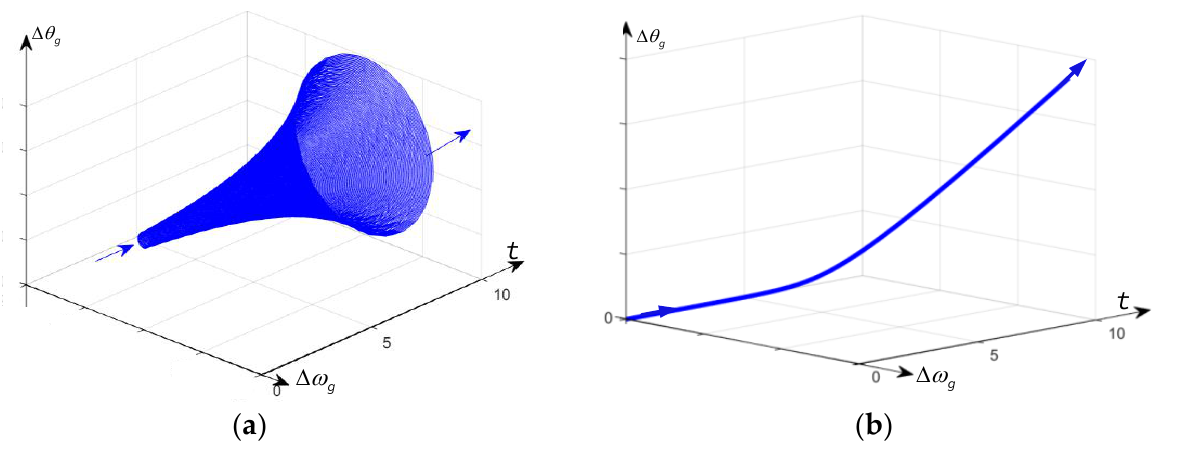
( b ) Figure 7. Phasor diagram for demonstrating the leading effect of damping torque on internal voltage stability: ( a ) normal condition; ( b ) abnormal condition with changed damping torque under dis- turbances. 3.4. Proposed Synchronverter Controller Design When disturbances such grid dip occur, the internal voltage of VSC in RPL is likely to oscillate and in turn deteriorate the APL stability. Since the droop coefficients in APL and RPL in synchronverters re hard to change due to the influence of steady-state droop characteristics, designing another auxiliary control loop would be a desirable method to improve the transient stability. In this paper, an auxiliary correction loop is proposed and added between APL and RPL, which is addressed by the red line in Figure 8; the power interface with the grid is the same as Figure 1 and neglected here. The input of the correc- tion control loop is Ψ f , and its output is obtained by the high-pass filtering of Ψ f , where D f is a tuneable parameter. The high-pass filter 1 f s D s s  +